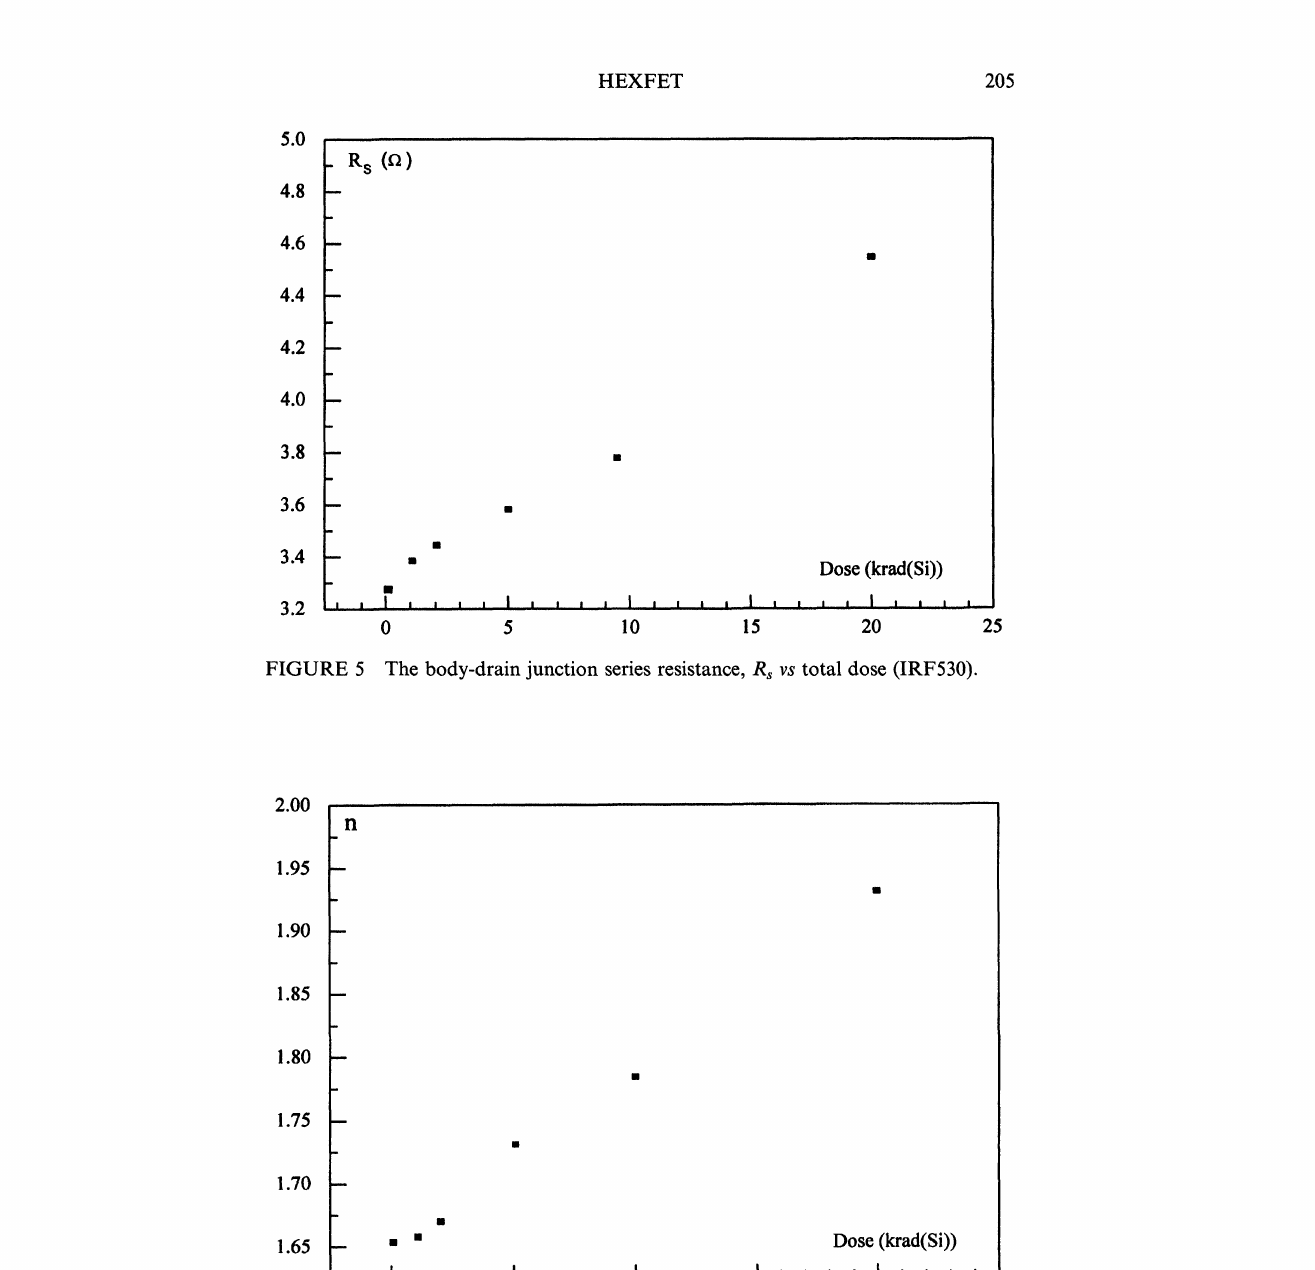
FIGURE 6 The body-drain junction ideality factor, n, vs total dose